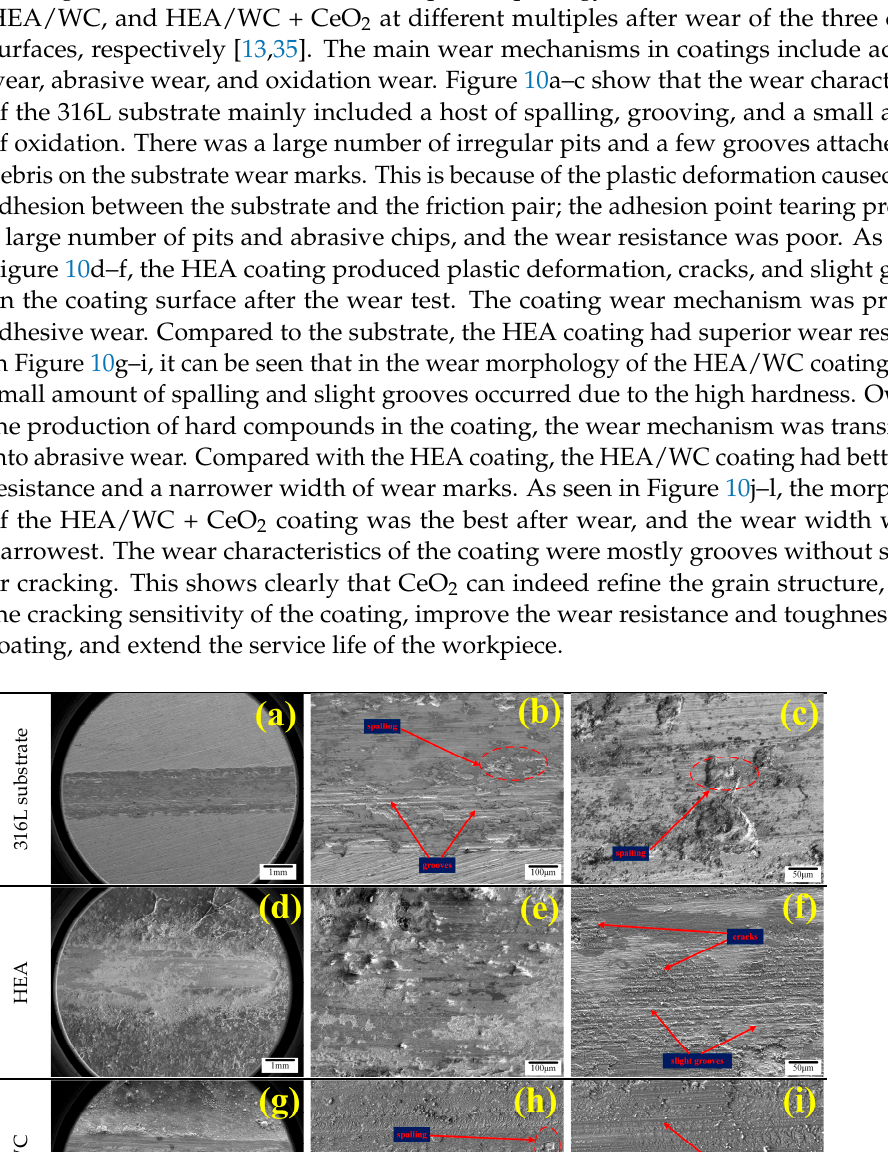
Figure 11. Curves of electrochemical corrosion results: ( a ) polarization curves; ( b ) Nyquist diagram; ( c ) Bode plot.